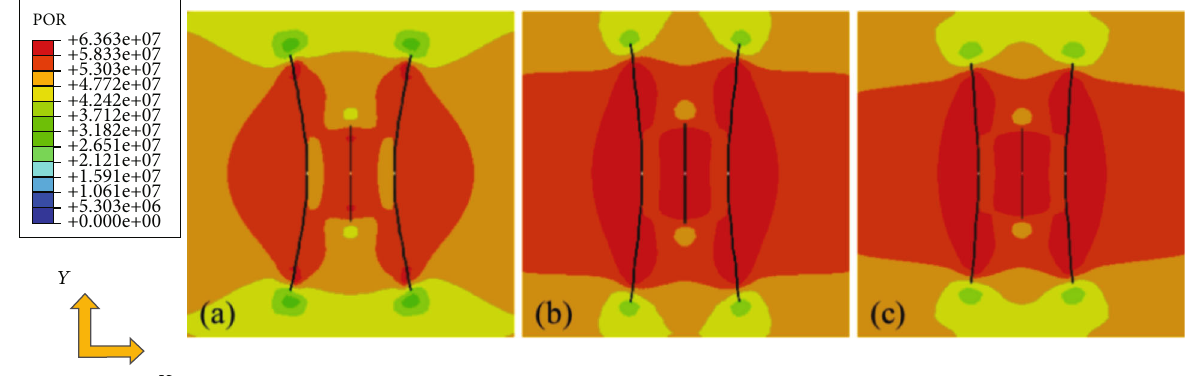
Figure 4: Single-stage simulation results with di ff erent initial in situ stress di ff erences: (a) stress di ff erence is 3 MPa; (b) stress di ff erence is 8MPa; (c) stress di ff erence is 15 MPa.